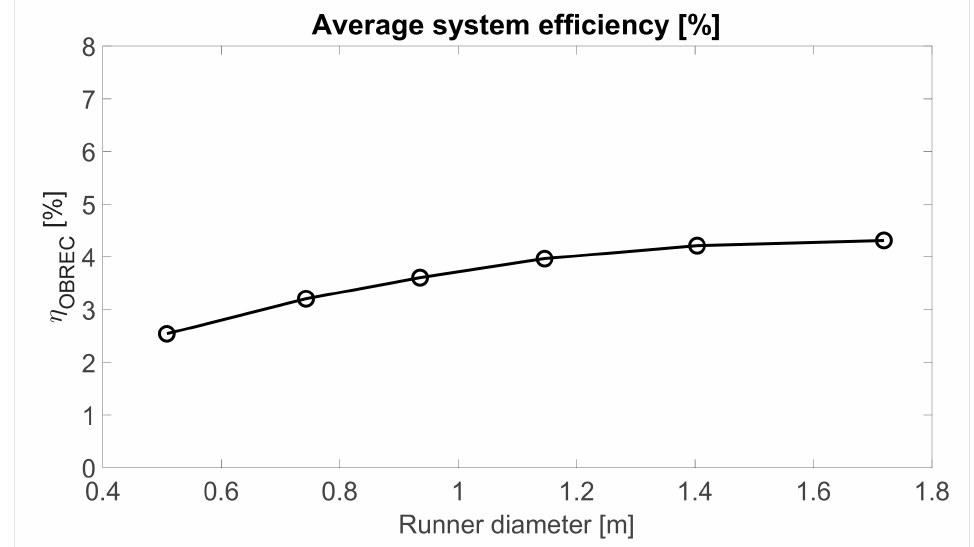
Figure 17. Average system efficiency as a function of the turbine runner diameter, at optimal